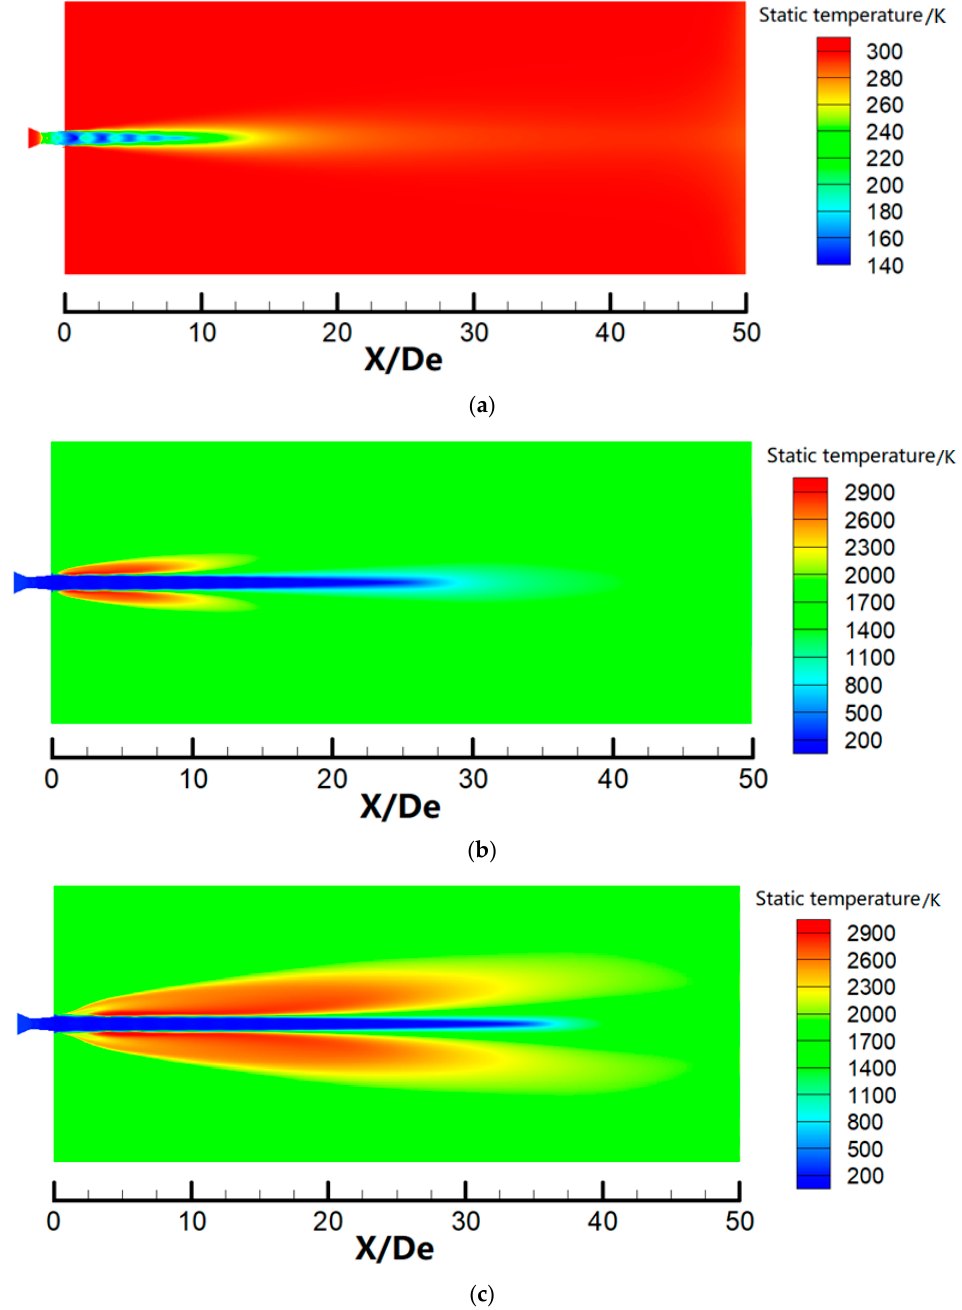
Figure 9. Static temperature contours for three jets: ( a ) supersonic jet; ( b ) coherent jet; and ( c ) SC coherent jet.